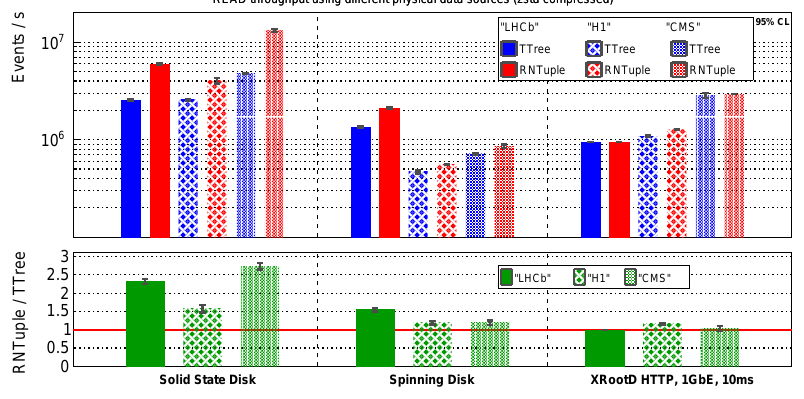
Figure 6. Read speed with di ff erent bandwidth and latency profiles. SSD benchmarks from machine 1, HDD and HTTP benchmarks from machine 2 connected to a dedicated, third XRootD server. Note that the SSD results on the left hand side are identical to the SSD / zstd results in Figure